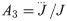
Normalized coefficient A3=J⃛/J at the peak of new cases per day.(a) The ratio A3/λ03 as a function of R0 is shown for different values of α. (b) The ratio A3/λ∞3 as a function of R0 for the same values of α. The dashed lines represent the values inferred from the data shown in Fig 3 for all cases (red) and fatal cases (blue). The shaded colored regions correspond to the uncertainties of the fits to the data.